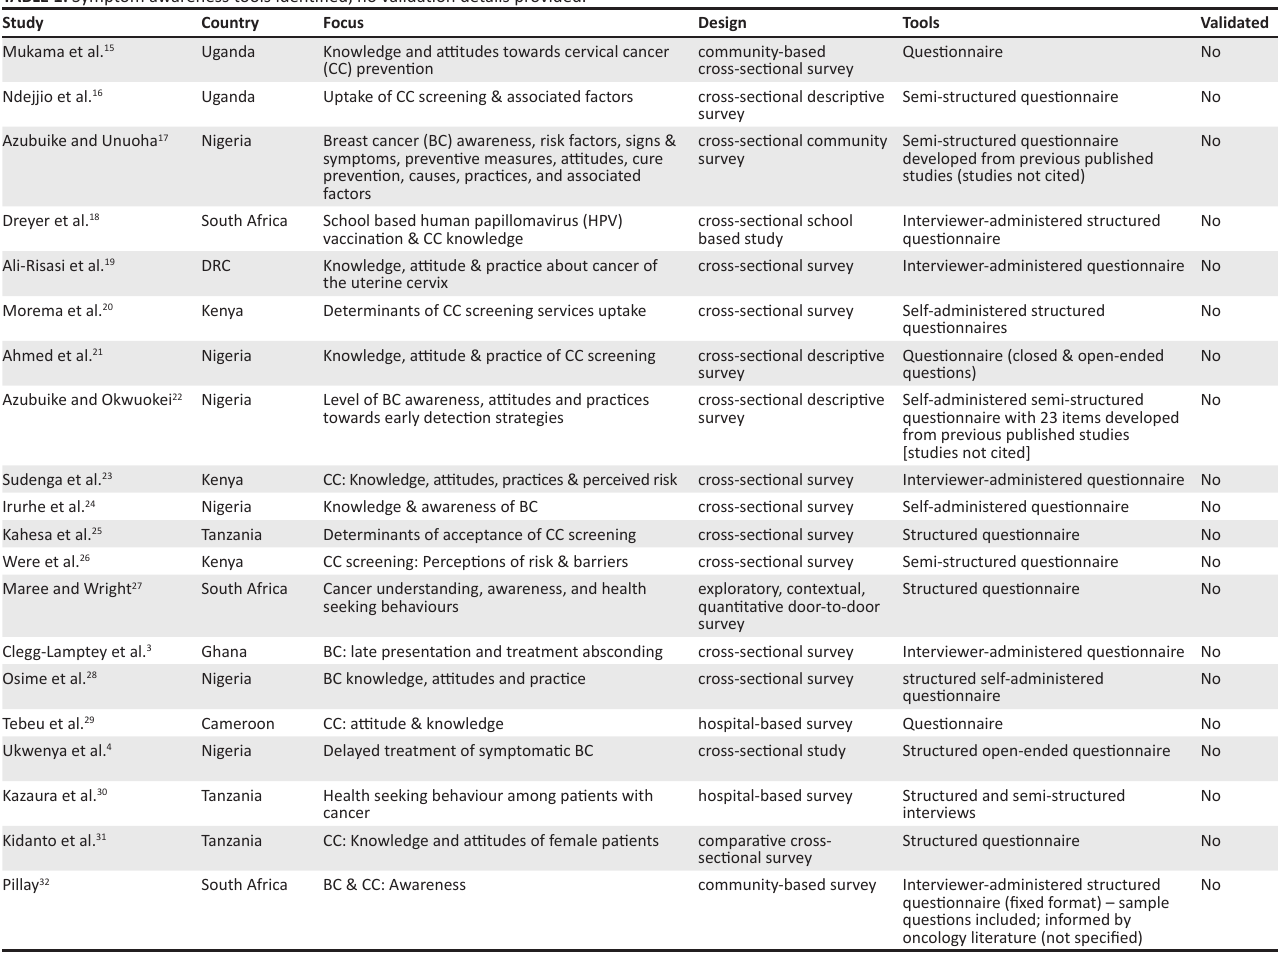
TABLE 1: Symptom awareness tools identified, no validation details provided. Study